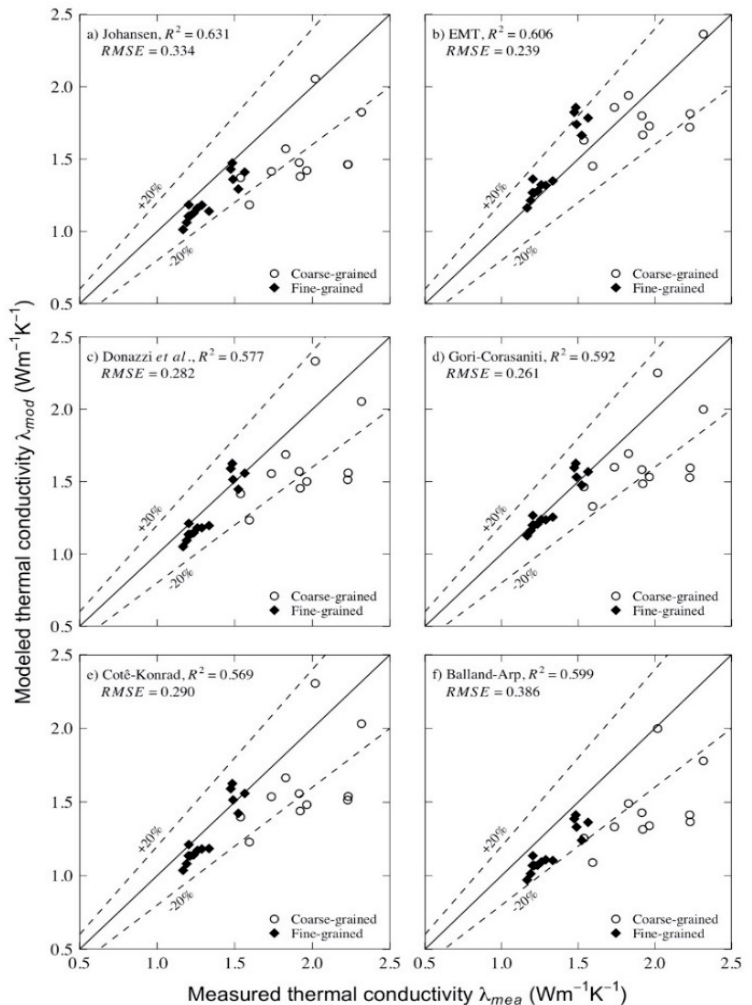
Figure 9. Measured thermal conductivity compared with the evaluated theoretical thermal conduc- tivity models: ( a ) Johansen; ( b ) EMT; ( c ) Donazzi et al.; ( d ) Gori–Corasaniti; ( e ) Cotê–Konrad; and ( f ) Balland–Arp.